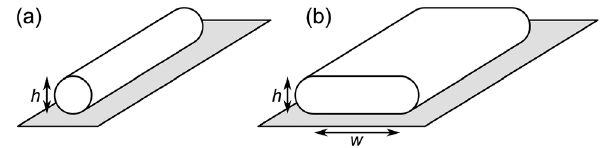
FIG. 12. Nanotube morphologies considered here. (a) When the adhesion between the (white) lipids and the (gray) adherent surface is very weak, the membrane shape is determined by the balance between its bending rigidity and its tension, resulting in a cylindrical morphology. (b) In the opposite limit of strong adhesion, the nanotube undergoes significant flattening ( w ≫ h